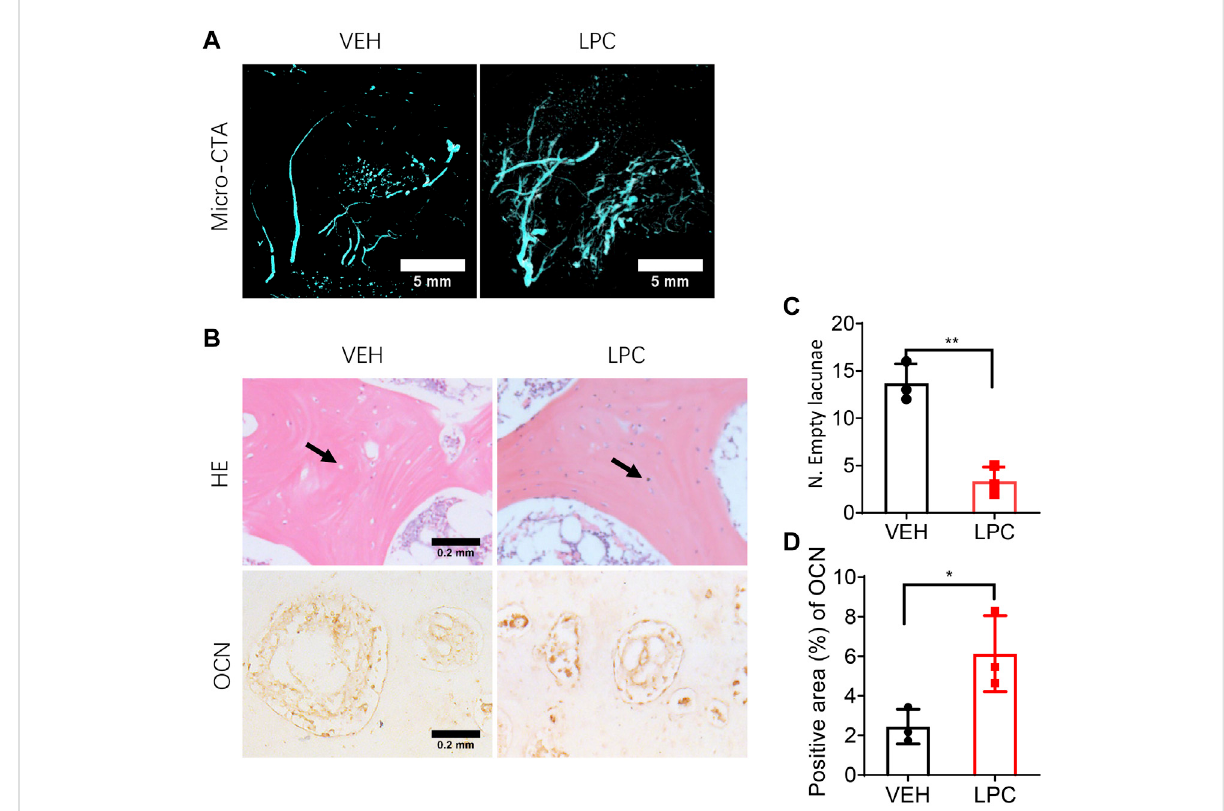
FIGURE 7 The effect of LPCs in vascularization and osteocyte generation. (A) Representative three-dimensional microcomputed tomography angiography ( μ CTA) images in the femoral head in control group and LPCs-treated group. (B) HE staining and immunohistochemical staining for Osteocalcin for both vehicle and LPCs cells treated groups. The black arrow shows osteocyte and lacunae. (C – D) Quantitative analysis of